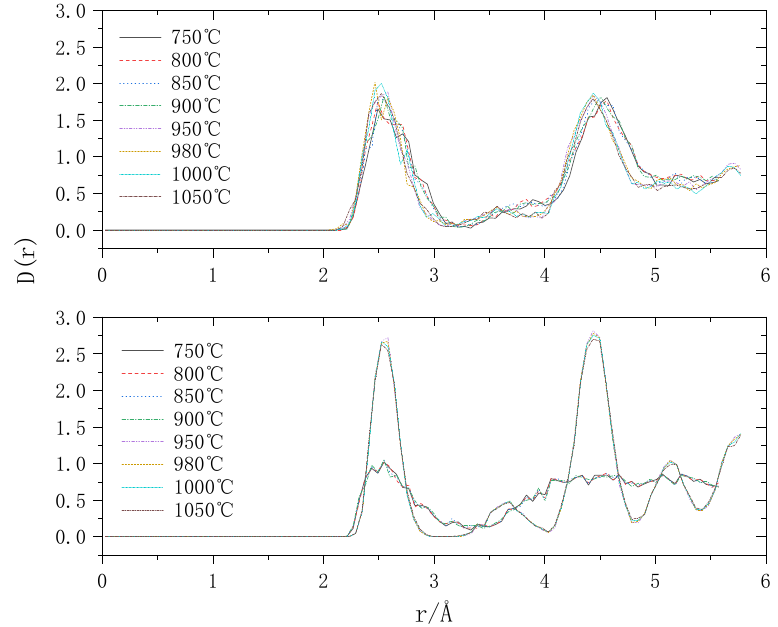
Figure 14. The RDF curves of Cu–Fe before and after diffusion under different temperature.